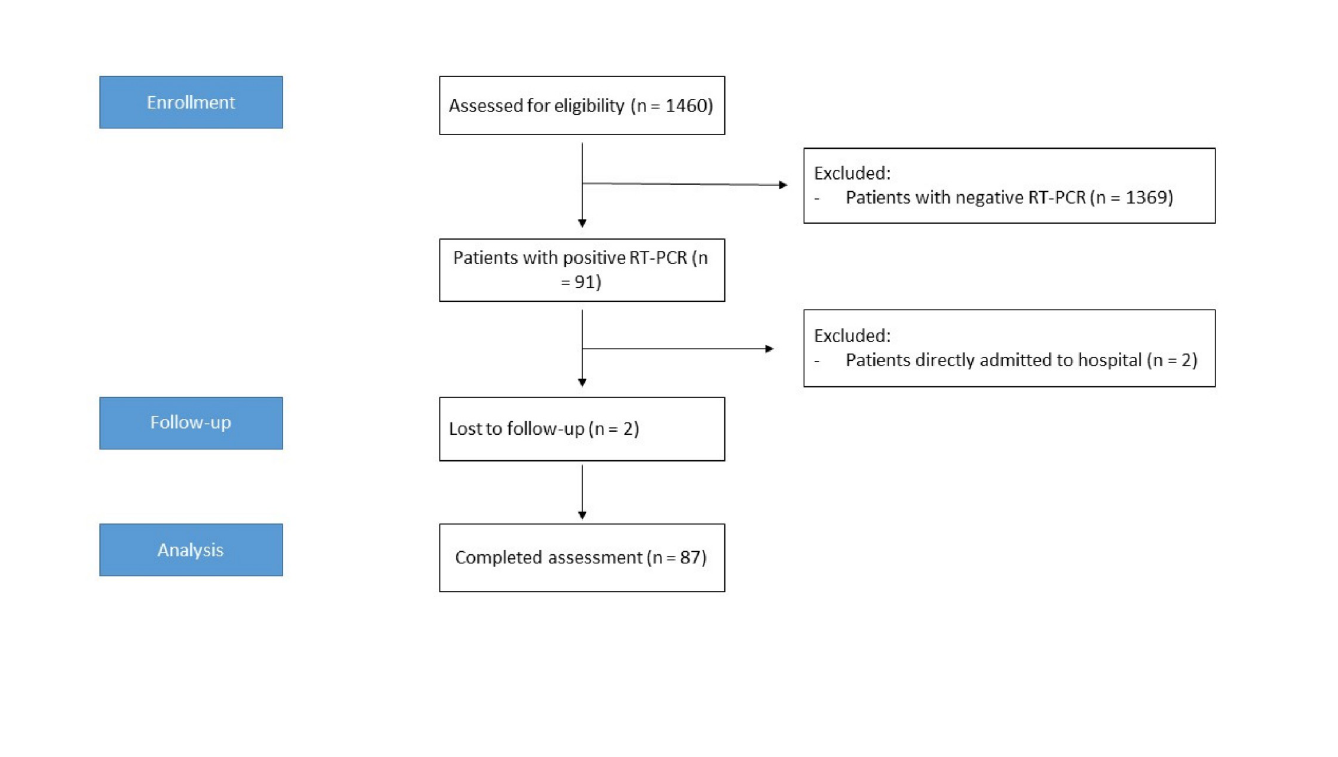
Fig 1. Diagram of enrollment, follow-up, and